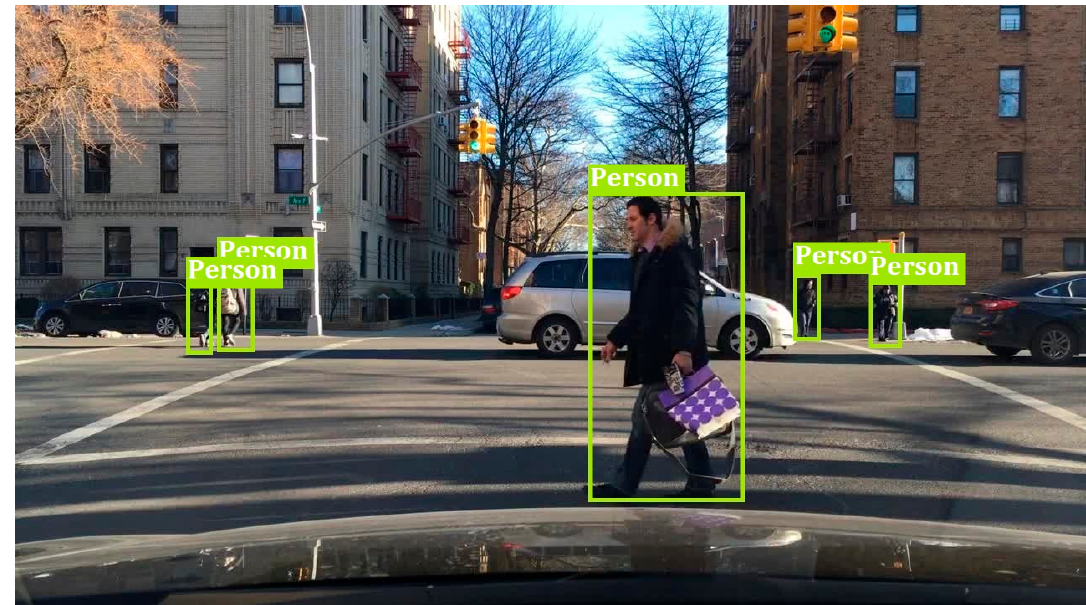
Figure 3. Sample object detection results on Test Image-Bdd100k Dataset.